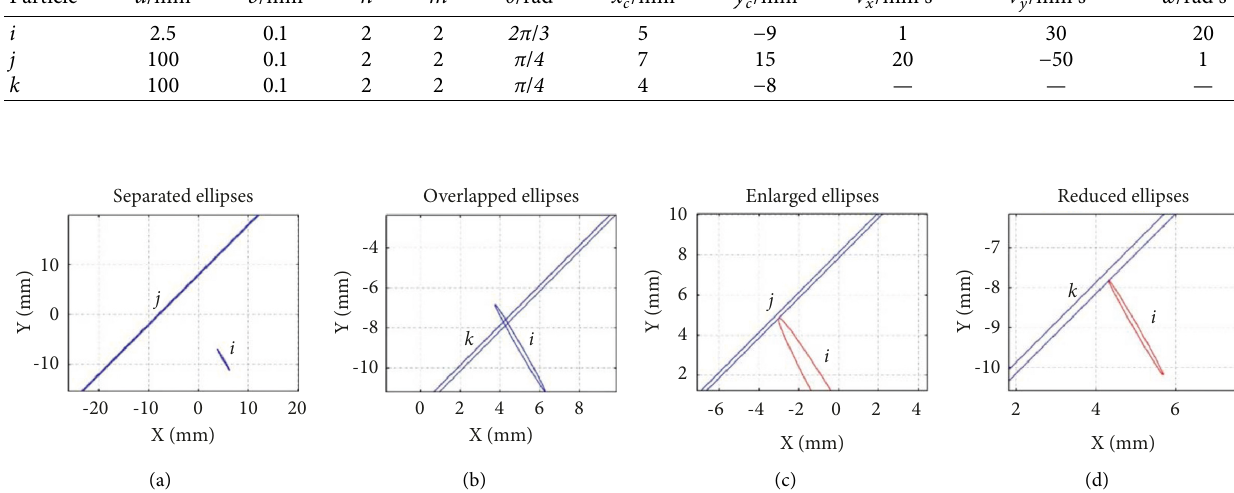
Figure 9: Contact detection of ellipses by using the grid method. (a) Separated ellipses. (b) Overlapped ellipses. (c) Enlarged ellipses. (d) Reduced